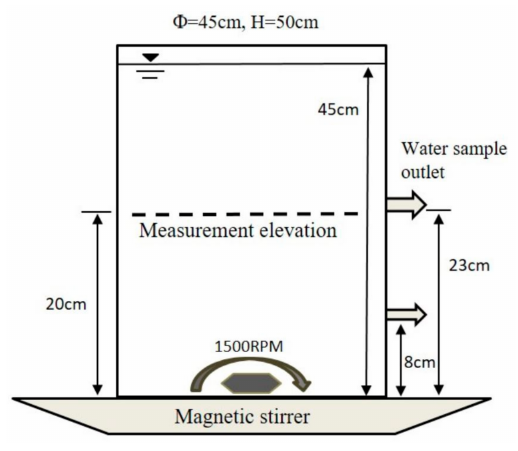
Figure 2. Diagram of experimental